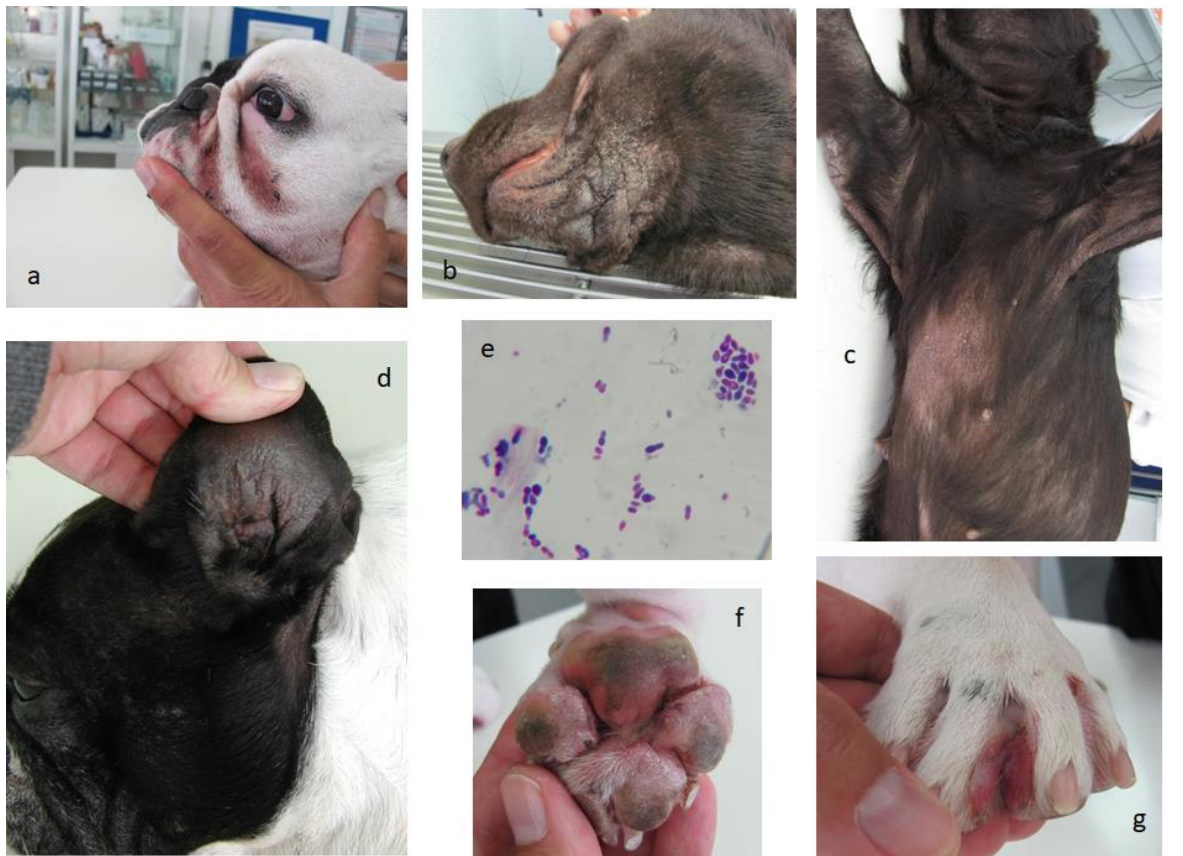
Figure 1. Chronic dermatitis in allergic dogs presenting Malassezia overgrowth. ( a ) Facial intertriginous dermatitis; ( b ) Lichenification associated with chronic dermatitis; ( c ) Hyperkeratosis and early lichenification in chronic dermatitis; ( d ) Ear pinnae chronic dermatitis with lichenification; ( e ) Skin cytology showing Malassezia overgrowth ( 400x) (Diff-Quick stain); ( f , g ) Chronic interdigital dermatitis.